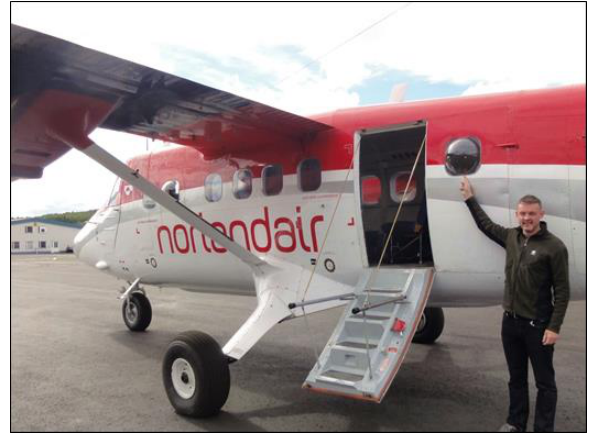
Figure 3. Survey aircraft used in 2016, a de Havilland DHC-6 Twin Otter with 2 sets of bubble windows, one at the front and the other at the rear of the plane. (Photo by Rikke